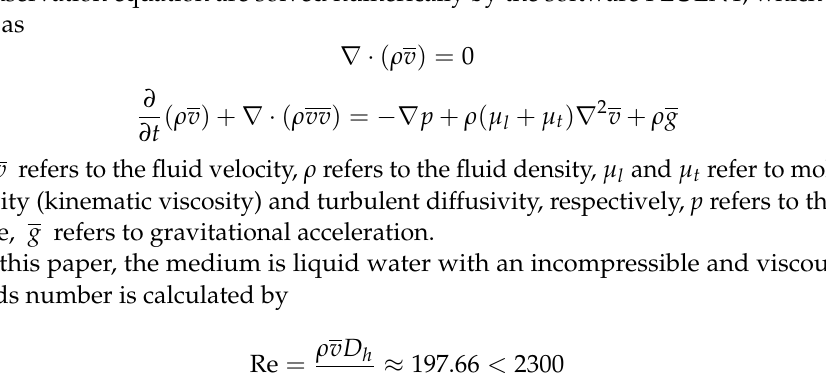
Figure 5. Quality check results of the generated mesh. The density and dynamic viscosity of liquid water are 998.2 kg/m 3 and 0.00103 kg/(m·s), respectively. The gravity of the liquid water and valve core is ignored. The inlet boundary is defined as the pressure-inlet increasing linearly as a function of time, i.e., the inlet pressure ranges from 0 to 6.0 kPa with an increase of 0.5 kPa per second. The outlet pressure is set to atmospheric pressure. The dynamic mesh method and the User Defined Functions (UDF) are adopted. Friction between spool and body is ignored in UDF. Solving equations based on the SIMPLE algorithm are adopted. To verify the reliability of numerical methods and simulation results, a comparison with similar simulations and experiments is conducted. Chappel et al. [33] conducted an experiment and simulation analysis of the flow rate of an MPV. The working principle and structure of the MPV in this paper are similar to those in the literature [33]. In the main parts of their paper, the inlet pressure with linearly increasing was adopted to sim- ulate the flow characteristics in the valve, similarly, the same inlet boundary condition is chosen in this paper. Their research results show that the numerical results are in good agreement with the experimental results, and the flow rate of the valve remains constant over a range of pressures. Thus, conclusions obtained from this work can be seen as reli- able.